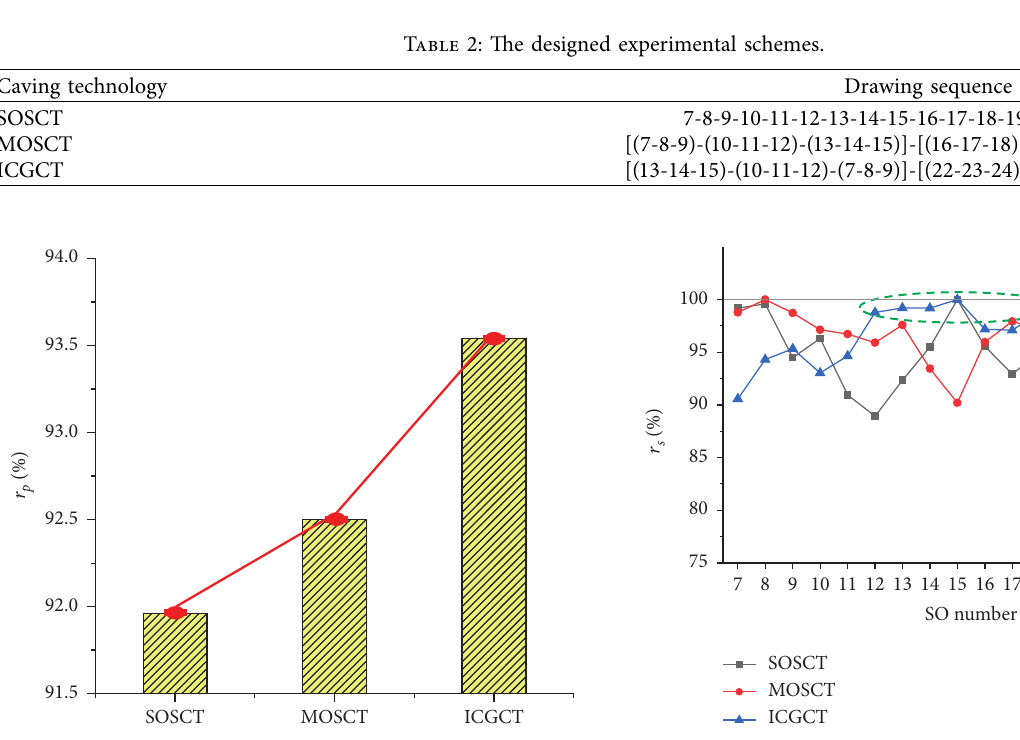
Figure 6: The variation of r p under three caving technologies.